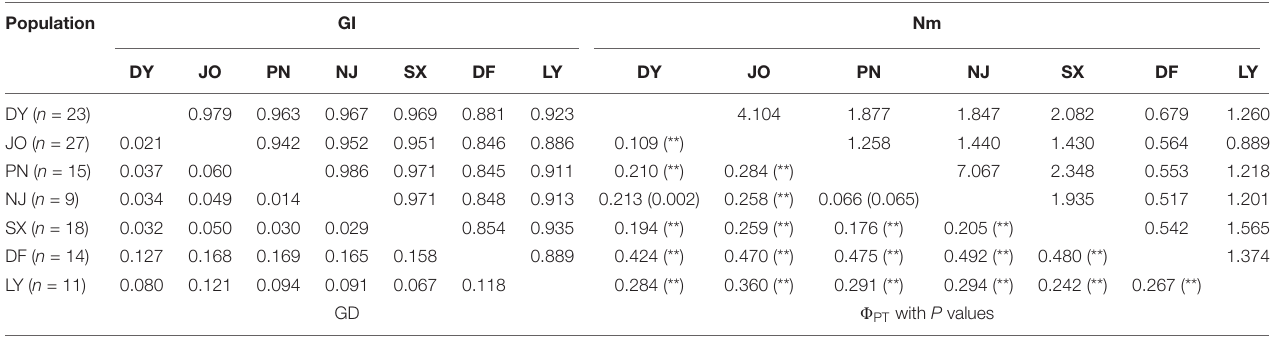
TABLE 3 | Pairwise matrices of Nei’s genetic identity (GI) and Nei’s genetic distance (GD), and gene flow (Nm) and genetic differentiation ( (cid:56) PT ) of regional populations of Setosphaeria turcica obtained from seven sweet corn-growing locations in Fujian Province, China. Population GI Nm